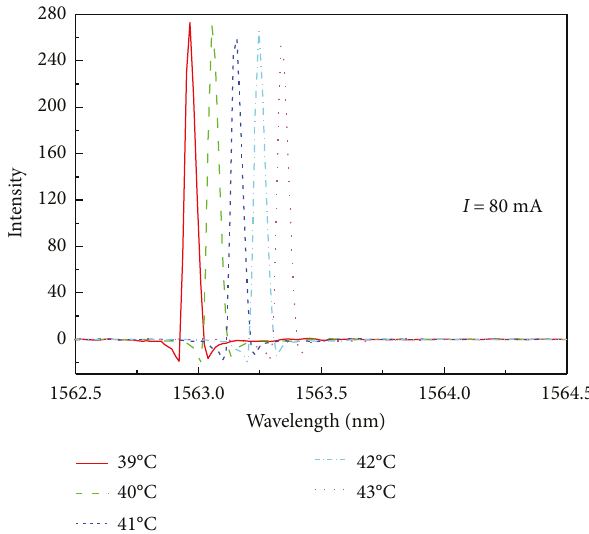
Figure 4: Center wavelength shifts while laser temperature is tuned linearly under constant injection